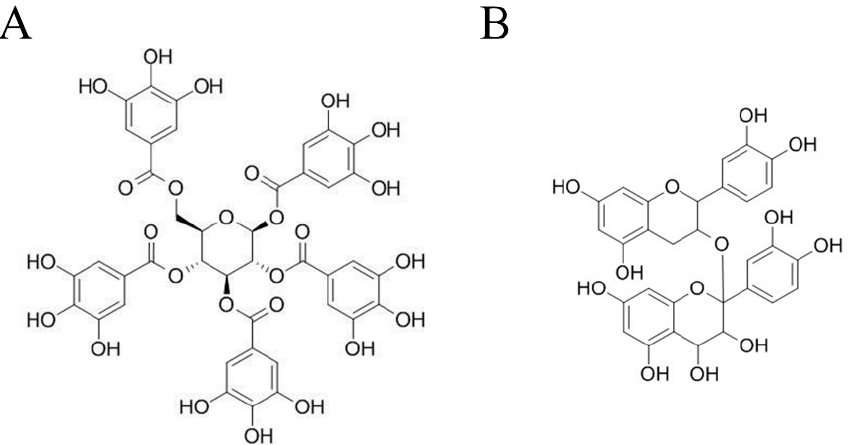
Figure 1. Chemical structure of 1,2,3,4,6-O-Pentagalloyglucose (PGG) ( A ) and Proanthocyanidins (PAC) ( B ).